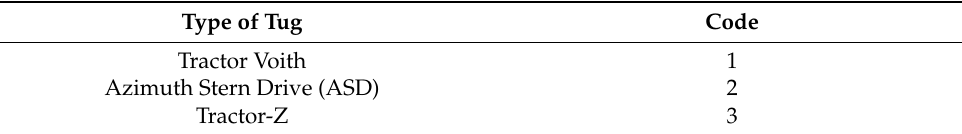
Table 2. Codification of Type of Tug